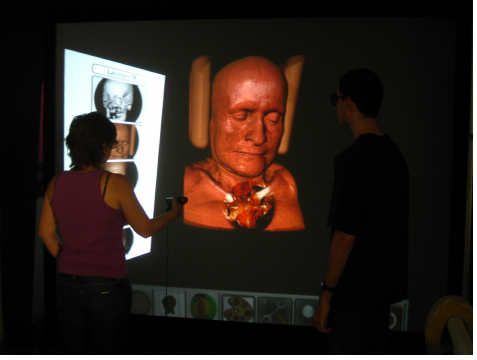
Fig. 2. Interaction session with our Virtual Magic